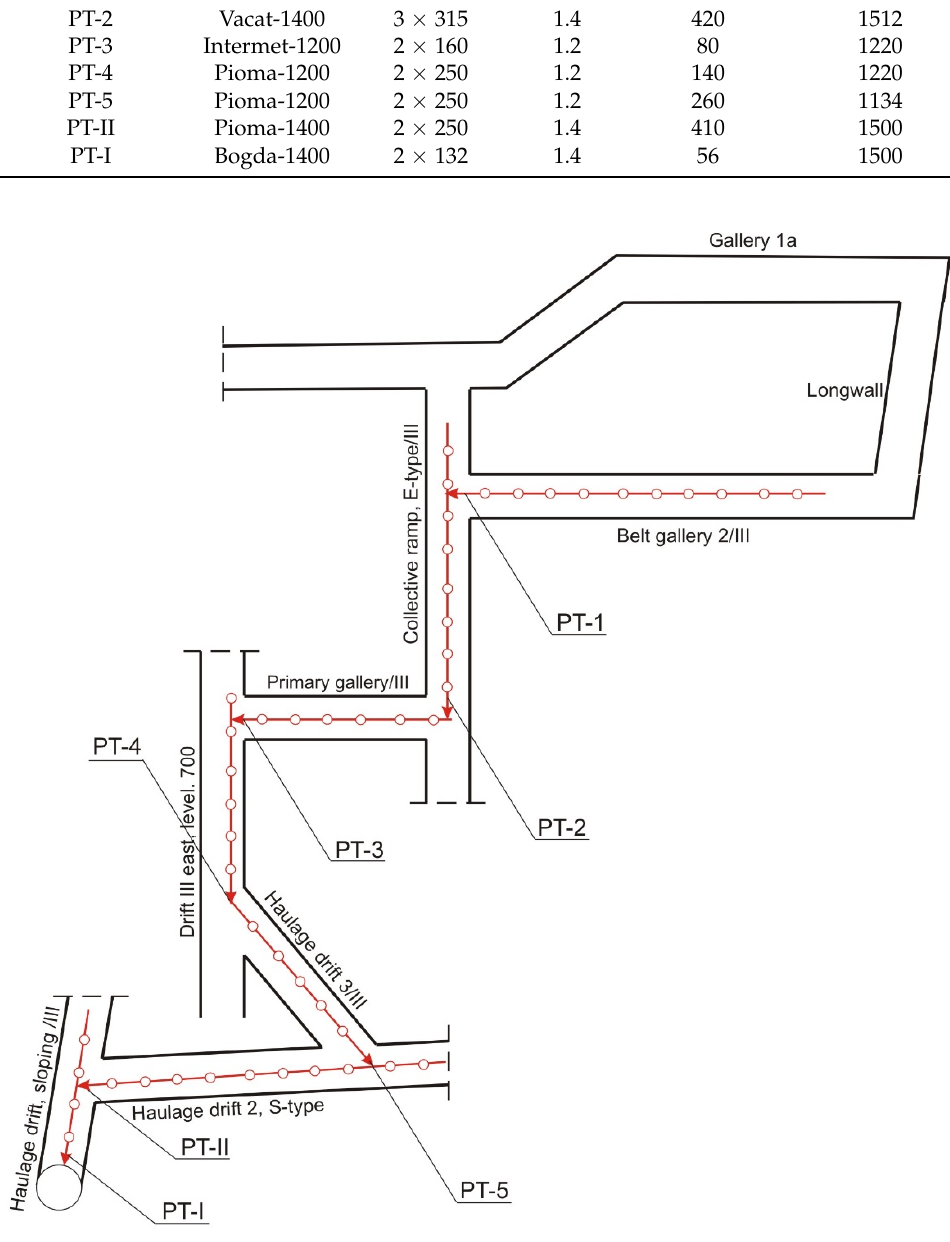
Figure 1. Layout of the conveyors of the main haulage system, (PT—a belt conveyor). Table 1. Technical parameters of the analysed main haulage